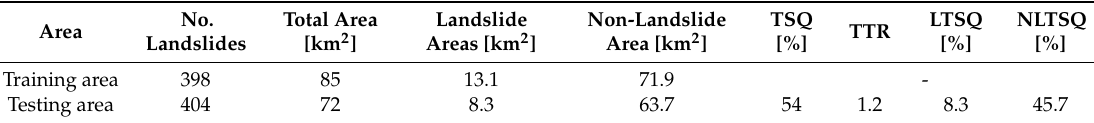
Table 4. Overview of the used training sample size in the natural boundary splitting design. For the explanation of the abbreviations, see Table